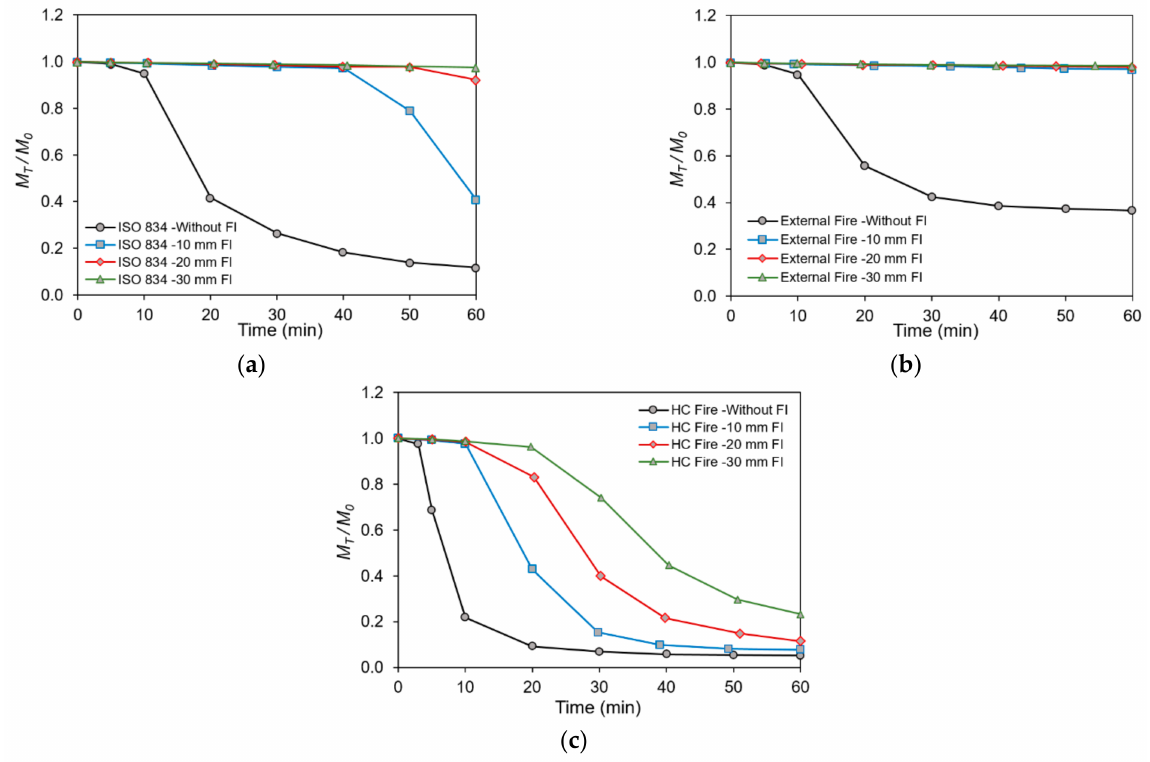
Figure 14. Reduction ratio of the composite beam with LC1: ( a ) ISO-834 fire; ( b ) External fire; ( c ) Hydrocarbon